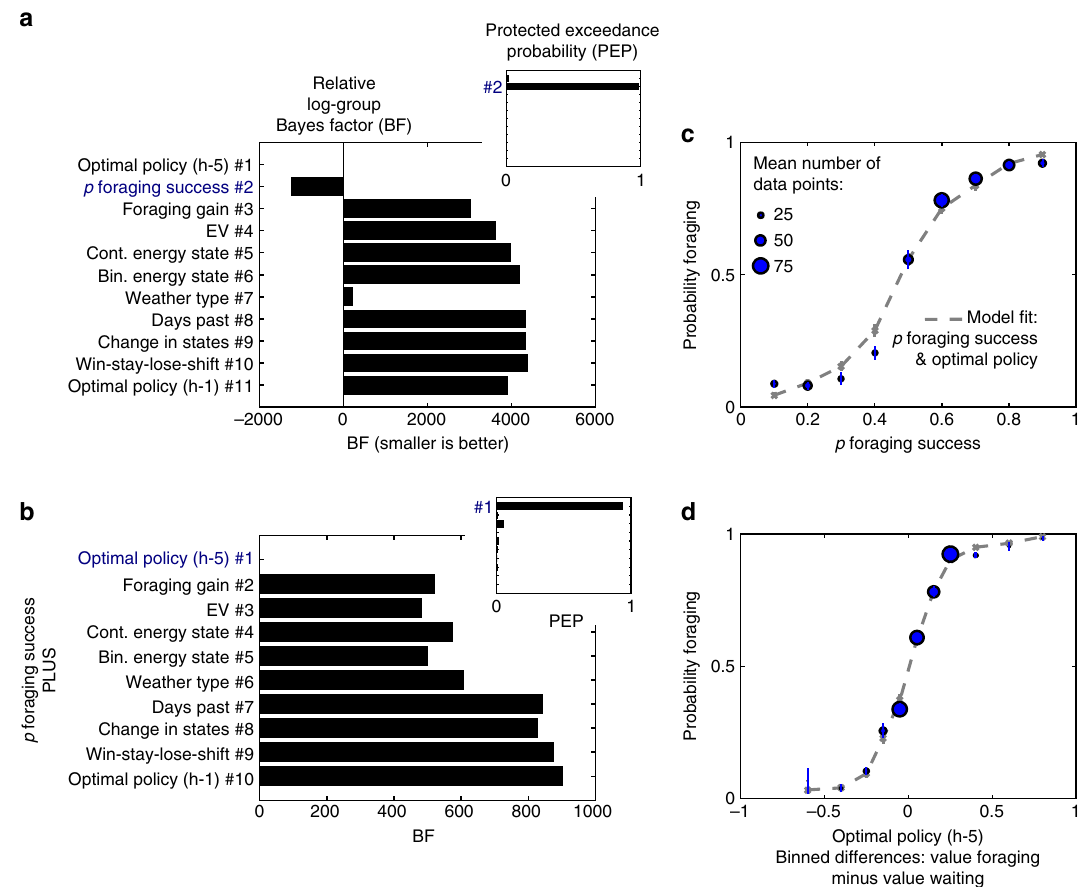
Fig. 3 Choice data and models of the fMRI sample. a Model comparisons show that the probability of foraging success was the best single predictor of participants ’ behavior. Main plots depict fi xed-effects analyses using log-group Bayes factors based on Bayesian Information Criterion (BIC) relative to model #1. Insets show random-effects analyses using protected exceedance probabilities (PEP) with the winning model marked. See Table 1 and Table 2 for lists that specify the task variables and thus the models tested here. b Crucially, the a priori optimal policy according to a time horizon of fi ve days best explained the remaining variance in participants ’ choices. c The winning model, which includes the probability of foraging success and the optimal policy, captures the empirical relationship between participants ’ average choices and the probability of foraging success. d The winning model captures the relationship between participants ’ average choices and the optimal policy according to a horizon of fi ve days (binned value differences of foraging vs. waiting). In the left-hand panels, blue font denotes the winning models. In the right-hand panels, error bars are SEM. Per data bin, circles depict mean empirical data points and lines and crosses depict mean model predictions (averaged for simulated data according to each participant ’ s model fi t). In several cases, error bars are smaller than the circles, which scale with the average number of trials contributing to the respective data points. See Supplementary Fig. 3 for the behavioral sample. See Supplementary Tables 1 – 4 for model comparisons. h-5: horizon of 5 days; h-1: horizon of 1 day; cont.: continuous; bin.: